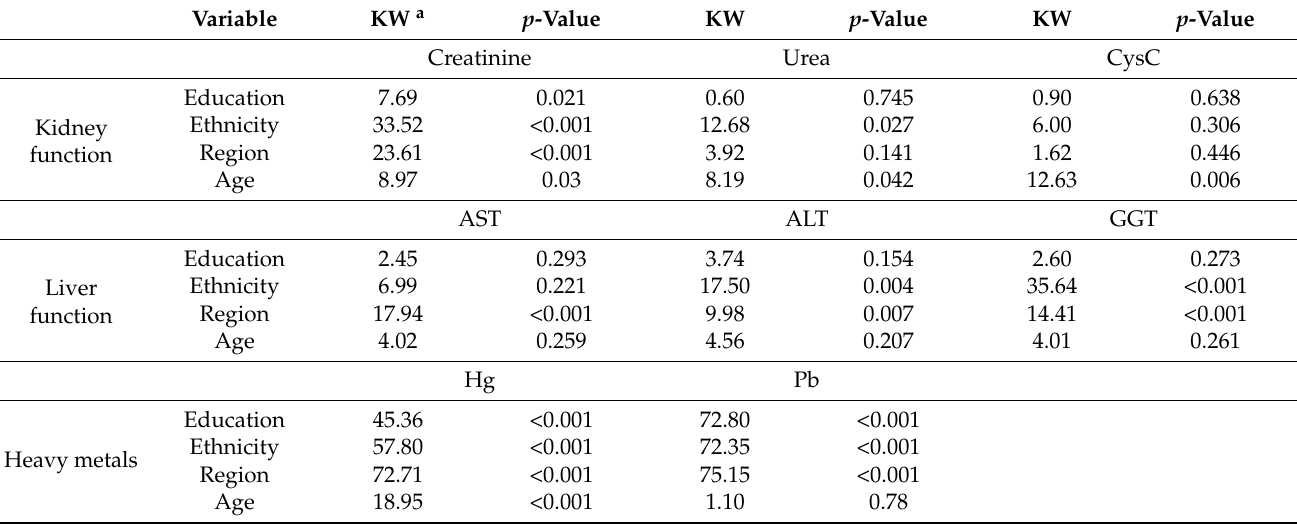
Table 3. Results of examining maternal demographic characteristics and biomarkers of effect (liver and kidney function) and exposure (mercury and lead in